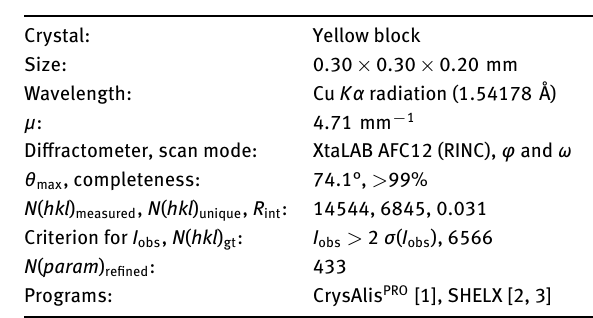
Table 1: Data collection and handling.